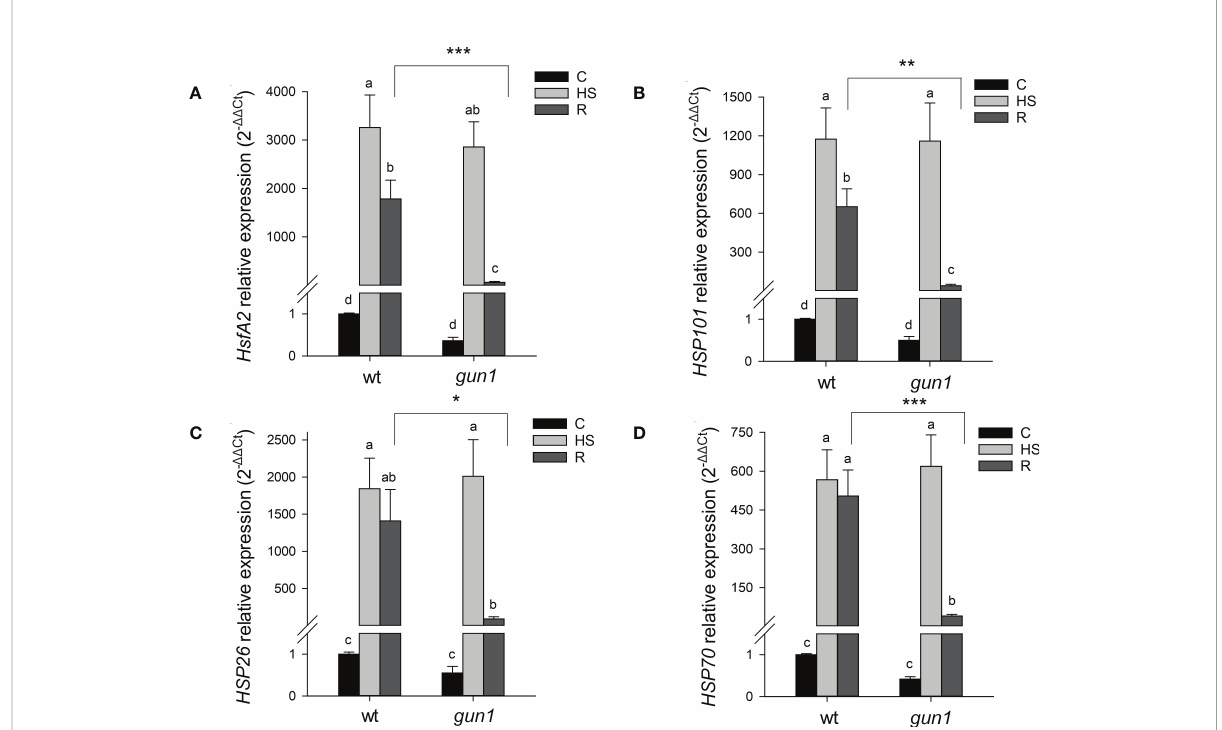
FIGURE 3 Relative expression of (A) HsfA2 , (B) HSP101 , (C) HSP26 and (D) HSP70 in 15 days-old wt and gun1 plantlets, grown at control temperature (C) or subjected to Heat Stress (HS; 2 hours at 45°C), followed by short recovery (R; 3 hours at 22°C). The expression level of HsfA2 and HSPs was normalized to that of Ubiquitin10 (At4g05320) and Actin8 (At1g49240) as internal references. For each sample, gene expression was related to the wt in control conditions (C) , set as 1. The values are the means ± SEs from three independent experiments, with three technical replicates for each experiment. Different letters indicate signi fi cant differences obtained by one-way ANOVA test (p< 0.05). T-test was applied to compare R samples among the genotypes. *p ≤ 0.05; **p ≤ 0.01; ***p ≤